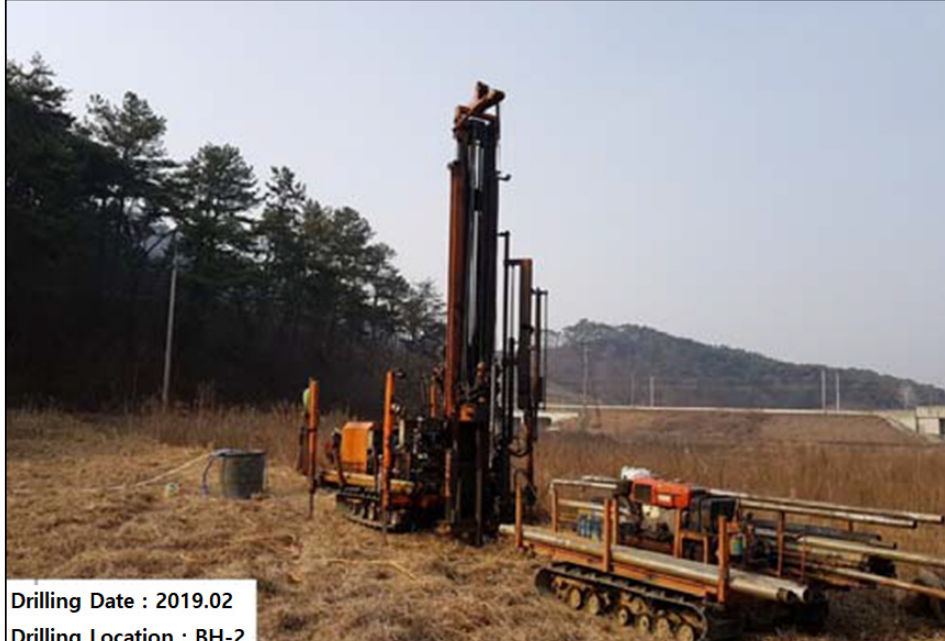
Figure 15. Rotary drilling rig using the NX-size core barrel ( φ 76 mm).